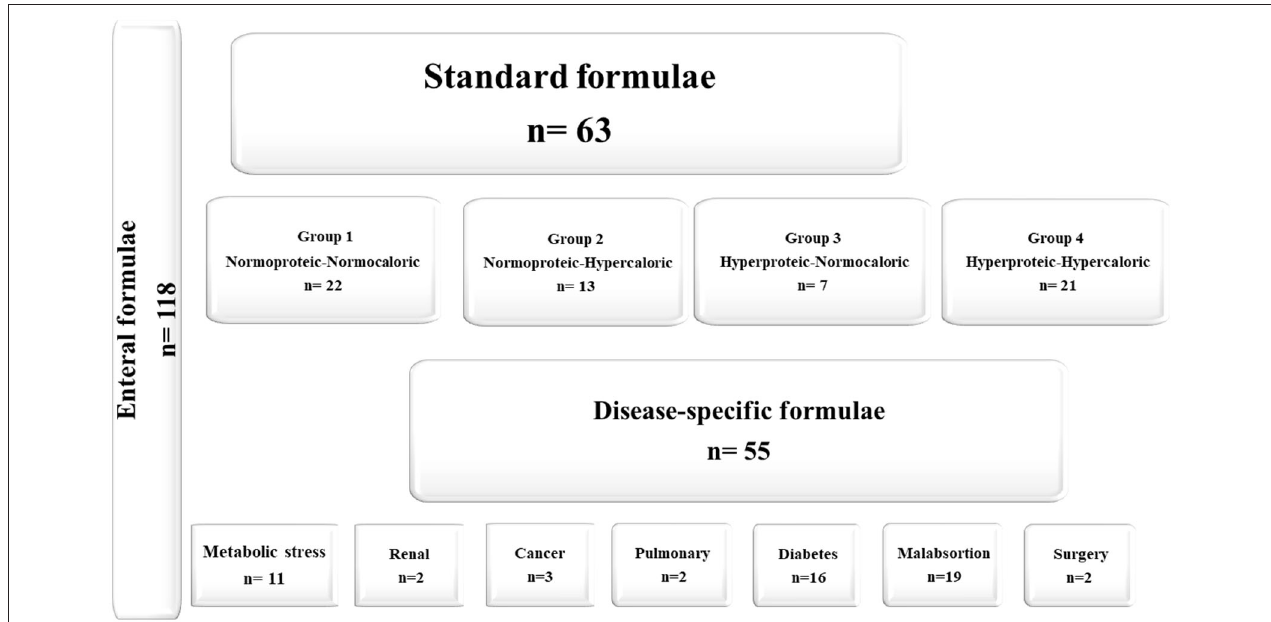
FIGURE 1 | Characteristics of the enteral formulae evaluated in the